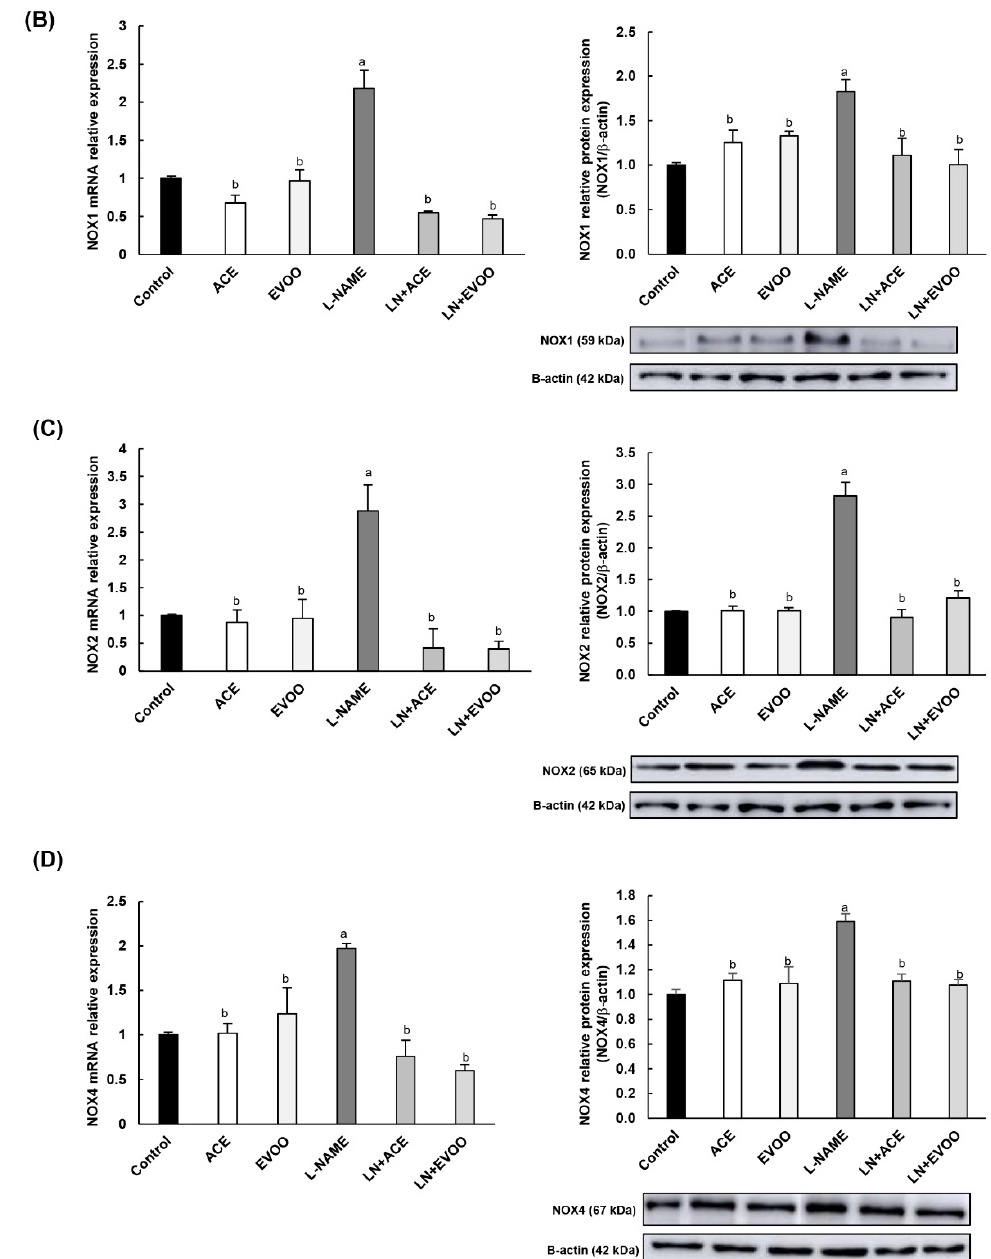
Figure 5. ( A ) NOX expression (red color) and double staining with DAPI (blue color) of NOX1 (top), NOX2 (middle) and NOX4 (bottom) in retinal layers from each experimental group. Magnification: 10×. mRNA and protein expression of ( B ) NOX1, ( C ) NOX2, and ( D ) NOX4 in retina homogenates from all groups. The quantitative fold changes in gene expression were determined relative to the corresponding value for the glyceraldehyde-3-phosphate dehydrogenase (GAPDH) housekeeping gene. Values are expressed as mean ± SEM of four animals per group: a p < 0.05 vs. control; b p < 0.05 vs. L-NAME. GCL: ganglion cell layer; IPL, inner plexiform layer; INL, inner nuclear layer; OPL, outer plexiform layer; ONL, outer nuclear layer; OS, outer segments; RPE/CH, retinal pigmentary epithelium/choroid.